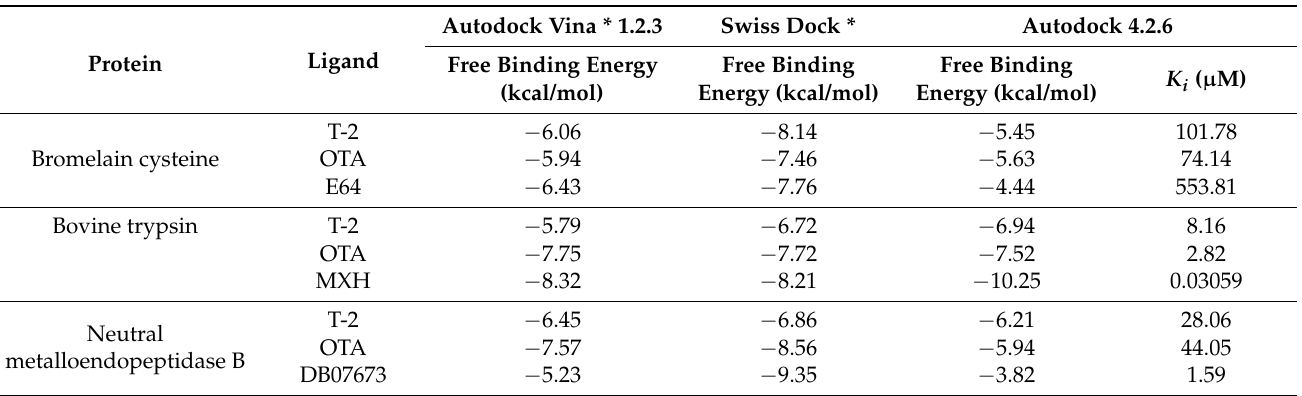
Table 2. Free binding energy and affinity ( K i ) of tested ligand–enzyme complexes were analysed with different scoring function